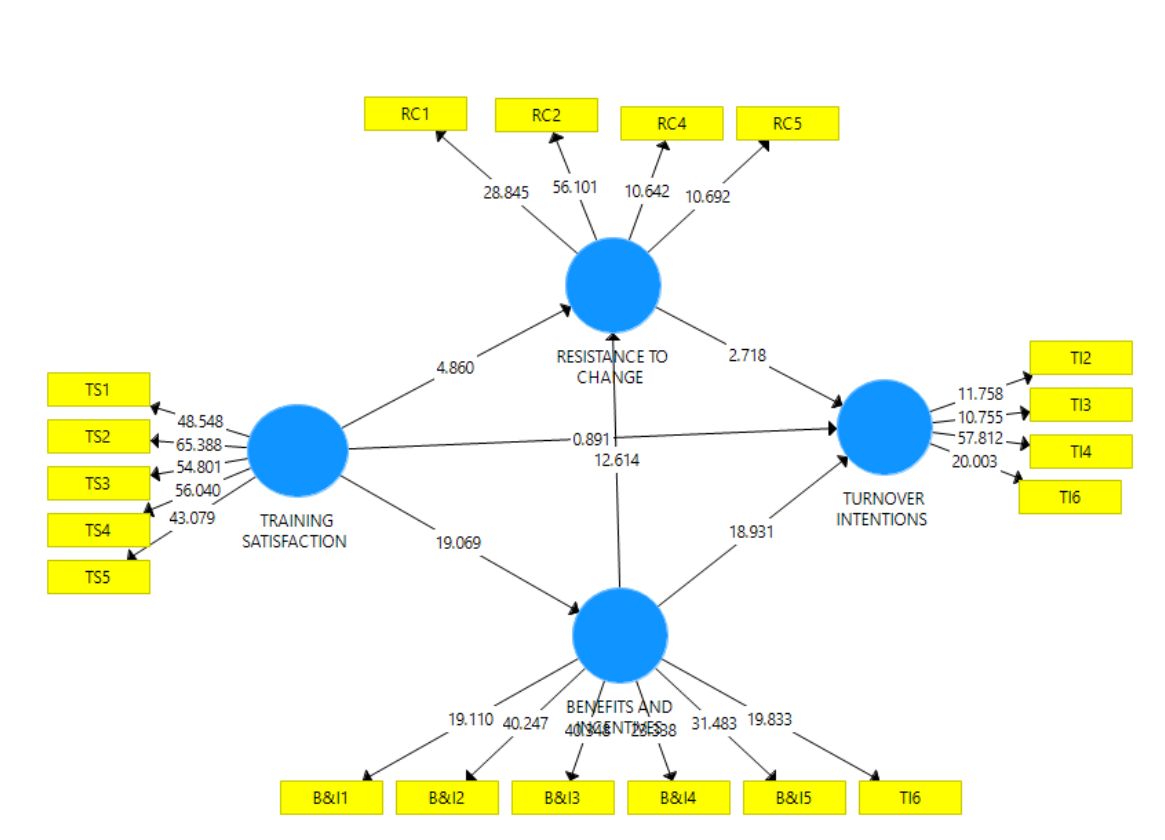
Figure A1. Estimated model from smart-PLS version